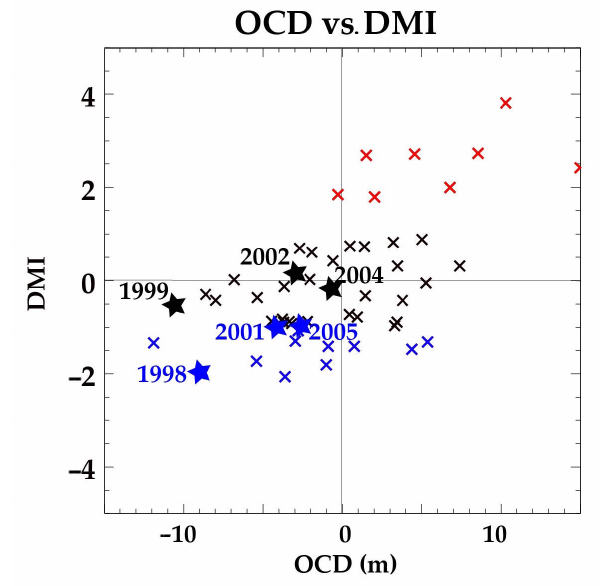
Figure 11. (a) Time series of fall interannual anomalies of modeled oxycline depth (continuous black line) averaged over the WCI box and modeled (continuous red) and observed (dashed red) fall DMI. (b) Time series of fall interannual anomalies of modeled oxycline depth averaged over the WCI box (black line) and zonal wind stress averaged over the southern tip of India (red line; STI box shown as dashed frame in Fig. 9b). (c) Time series of fall interannual anoma- lies of modeled oxycline depth (black line) and alongshore wind stress (red line) averaged over the WCI box. Upwelling-favorable winds in panel (b) and (c) are positive. Correlation coefficients be- tween the variables are indicated in each panel.